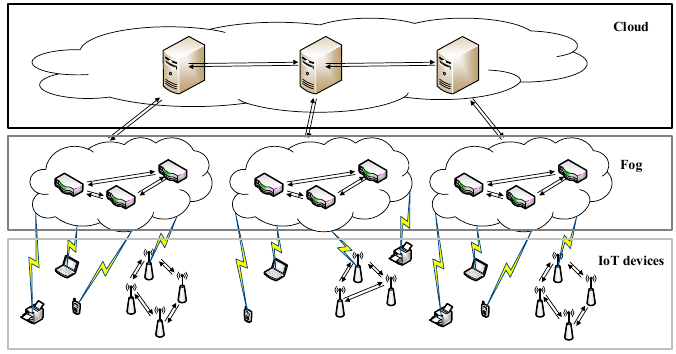
Figure 1. IoT architecture for fog computing.